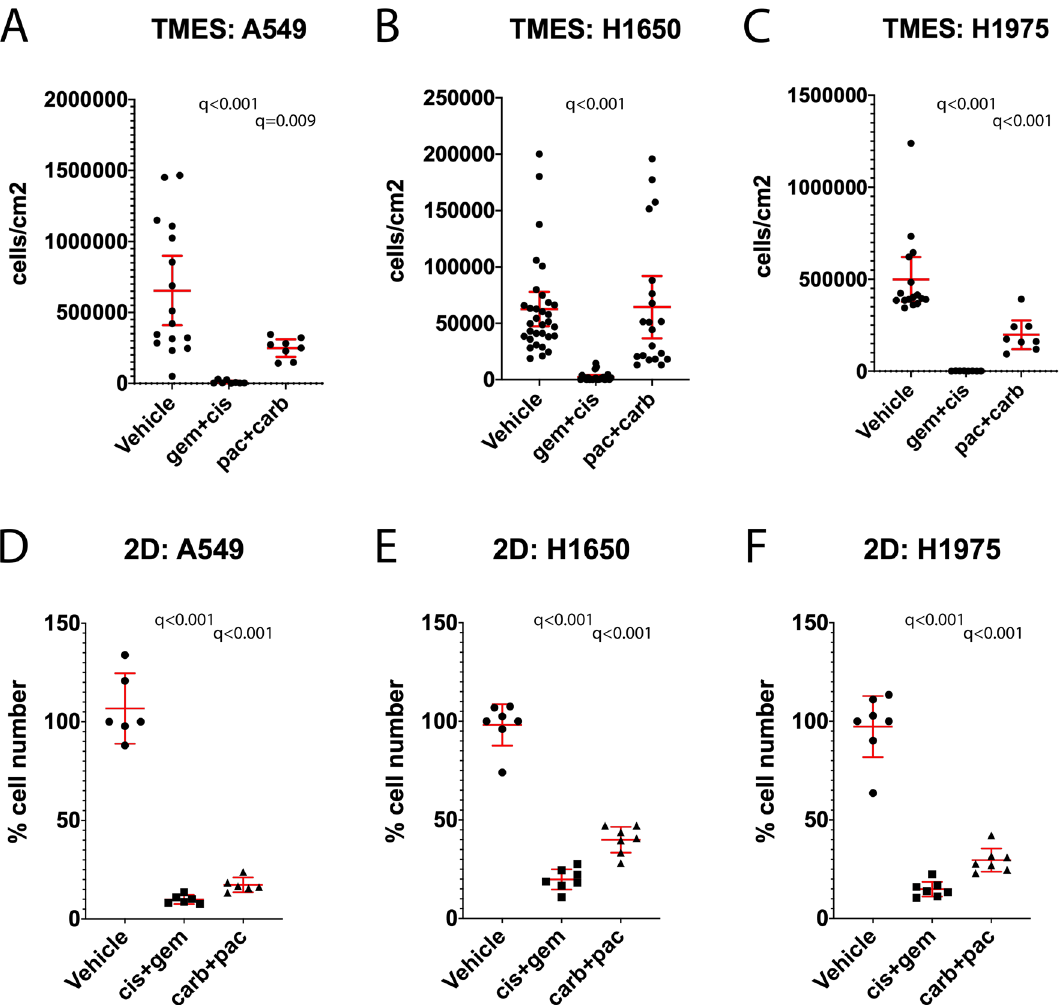
Figure 7. The NSCLC TMES responds to cytotoxic chemotherapies at human patient doses. NSCLC cells from A549 ( A ), H1650 ( B , D ), and H1975 ( C , E ) were grown in the TMES for four days and then dosed with either 35.4 μM gemcitabine and 6.5 μM cisplatin, 6.2 μM paclitaxel and 67 μM carboplatin for 3 days. Tumor cell number was determined using luciferase signal as a surrogate for cell number with a standard curve. Plotted are individual measurements of tumor cells across multiple TMES device runs with the mean and 95% confidence intervals shown in red. ANOVA followed by two stage step up method of Benjamini, Krieger and Yekutieli to control for the FDR, relative to control; q values reported on the